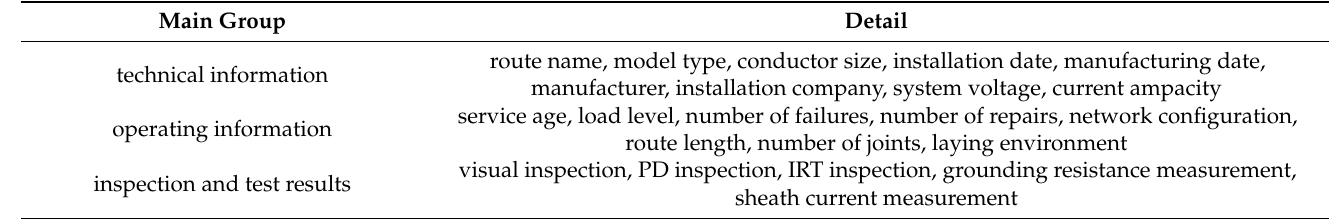
Table 1. Data requirement for HI calculation